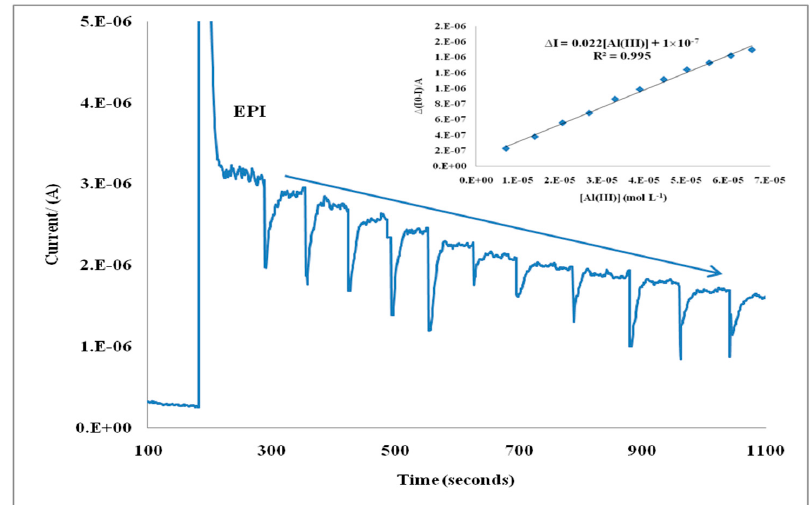
Figure 11. Amperometric recording performed with SOD/PdNPs/SPC TTF E, prepared under method B and CV2 conditions, [EPI] = 1.6 × 10 − 4 M and consecutive additions of 100 μ L of Al(III) 3.7 × 10 − 4 M into the cell, Britton Robinson buffer pH 5.0, Eap = +0.20 V vs. Ag/AgCl. Inset: Calibration curve corresponding to this amperogram.